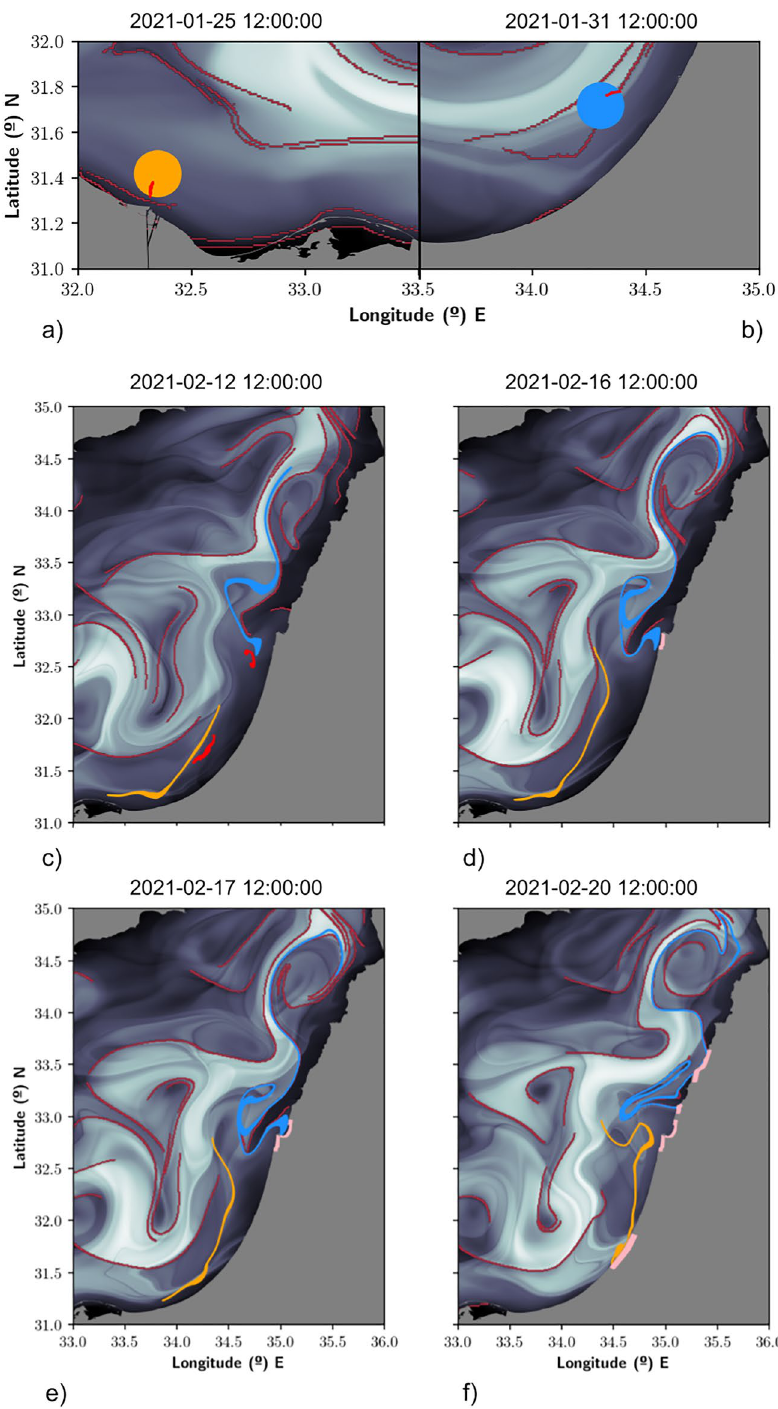
Figure 3. Simulations that reproduce the spreading on the sea and the arrival of the oil to the coast. The function M at the background is represented at t 0 equal to the corresponding date. ( a ) 1st release on the 25th January 2021 and satellite observation; ( b ) 2nd release on the 31st January 2021 and satellite observation; ( c ) evolution on the 12th February 2021 and satellite observations; ( d ) evolution on the 16th February 2021 and arrival to the coast; ( e ) evolution on the 17th February 2021 and arrival to the coast; ( f ) evolution on the 25th February 2021 and arrival to the coast. These masks indicate regions that correspond to the continental shelf. These figures have been created with Python 3.9.2 (https:// www. python. org/ downl oads/ relea se/ python- 392/). The maps shown have been generated with a mask provided by OpenStreetMaps (https:// osmda ta. opens treet map. de/ data/ land- polyg ons.